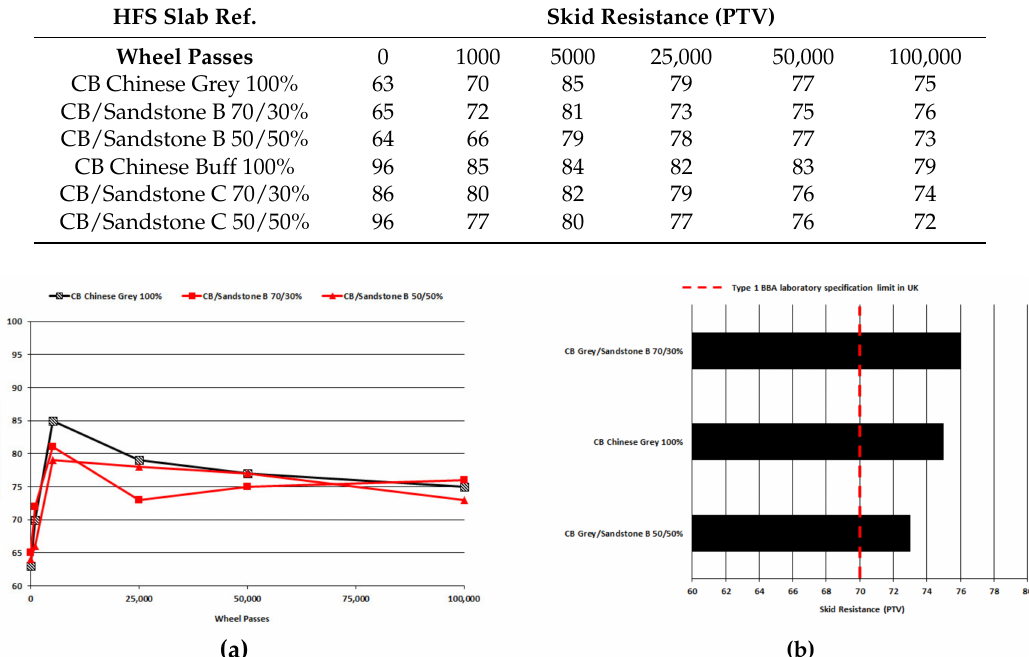
Table 4. Skid resistance data (Ulster University data). HFS Slab Ref.